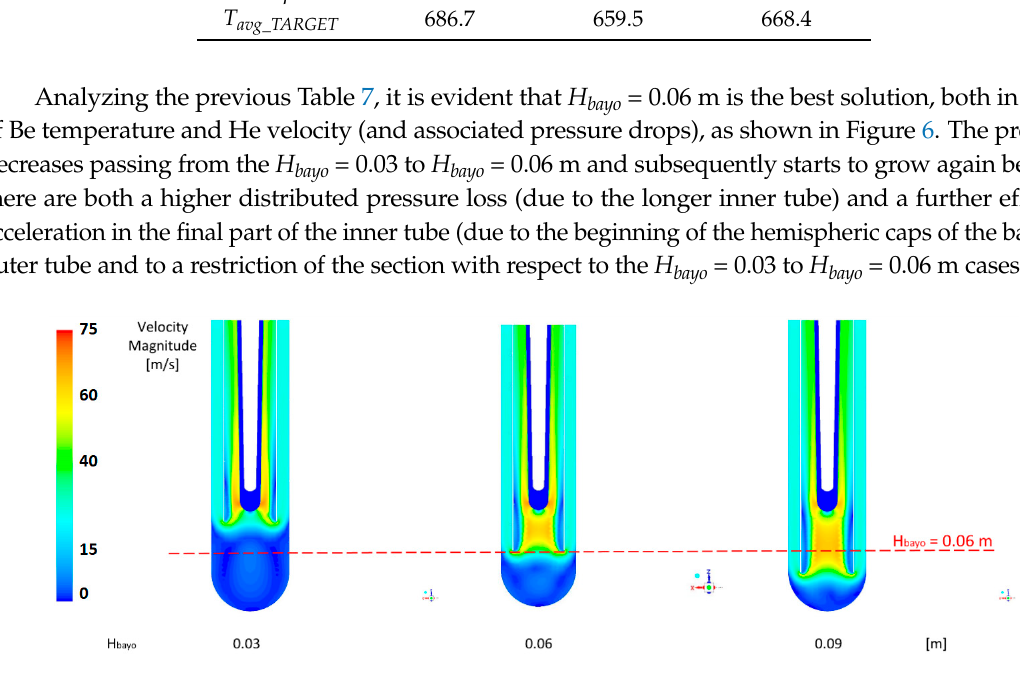
bayo equal to 0.03, 0.06 and 0.09